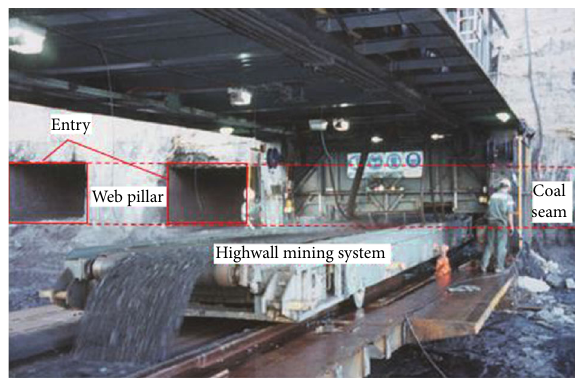
Figure 1: A continuous highwall mining system